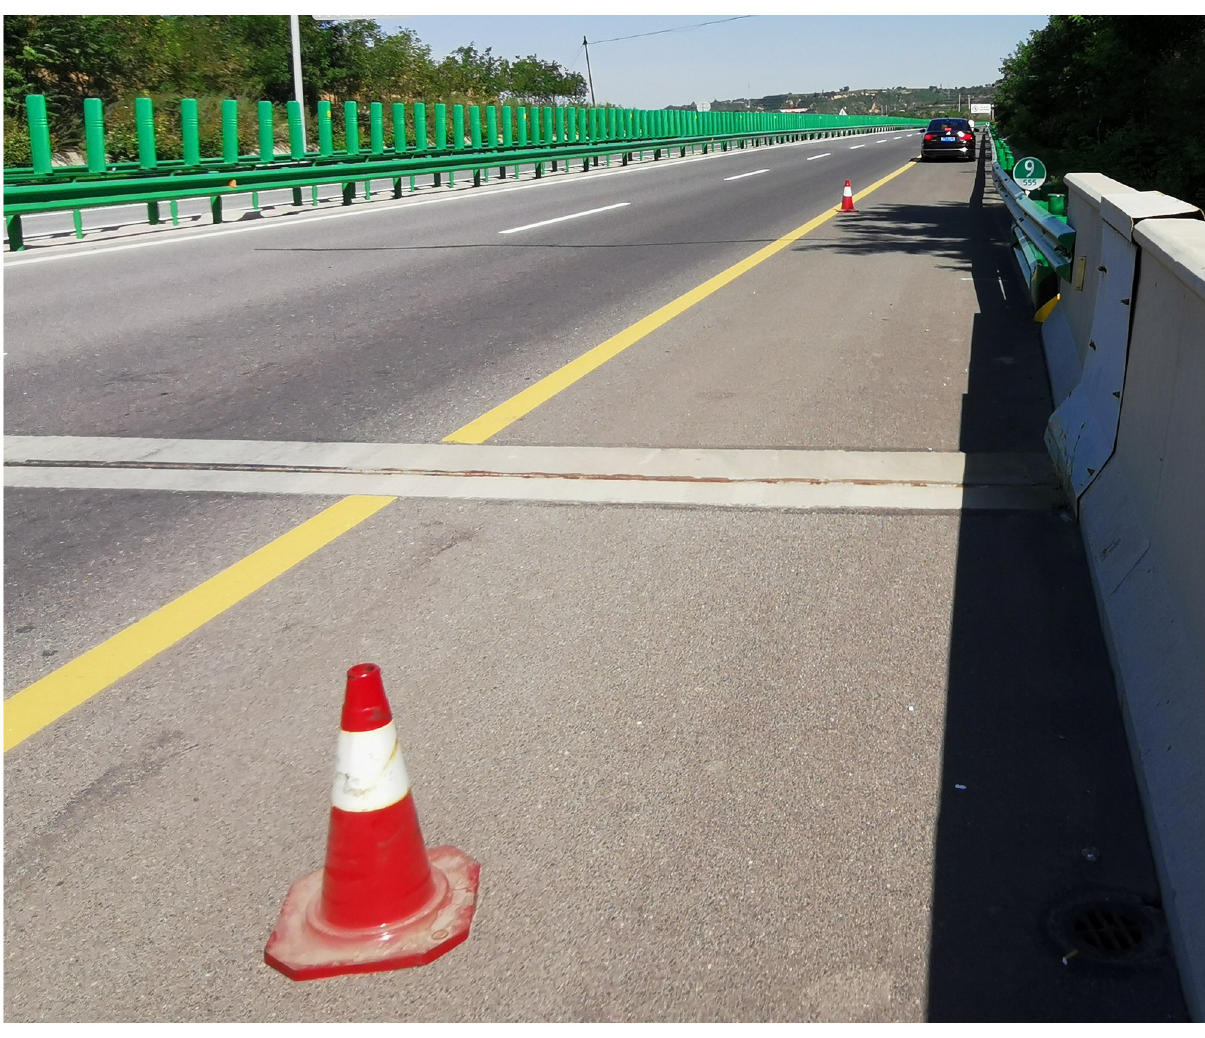
Fig 10. Real picture of field